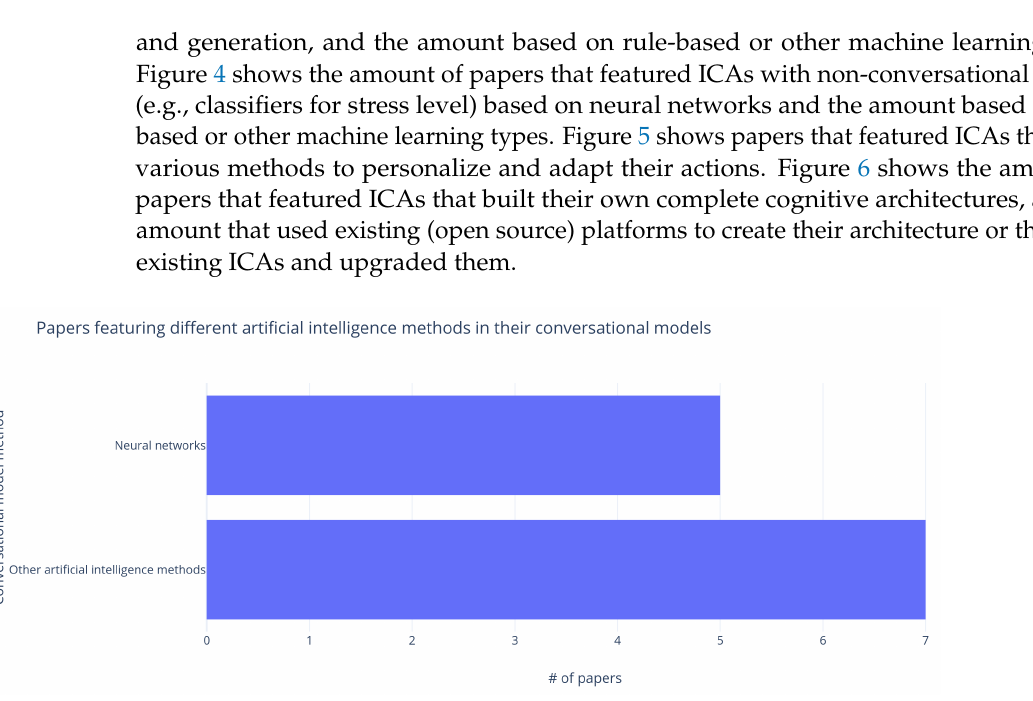
Figure 3. Papers featuring different AI methods in their conversational models. Some systems use neural networks as well as other AI methods, which puts them into both categories.